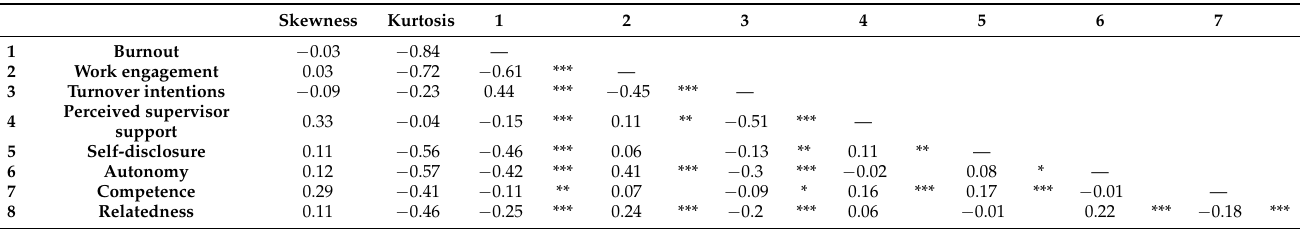
Table A3. Correlations between basic psychological need satisfaction in autobiographical memories, self- disclosure, perceived supervisor support, wellbeing, and turnover intentions. Skewness and kurtosis.